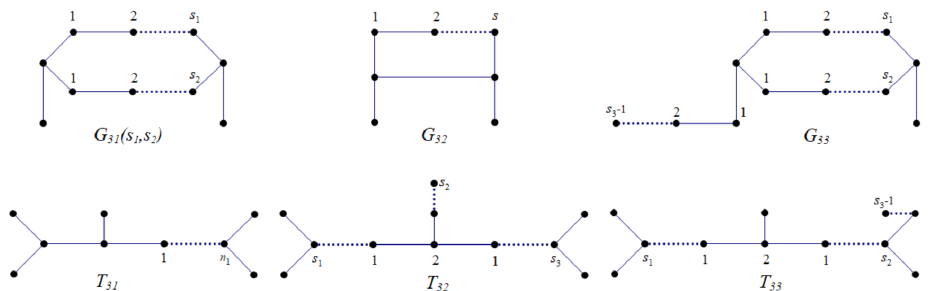
Figure 3. Some graphs in G 3 and T 3